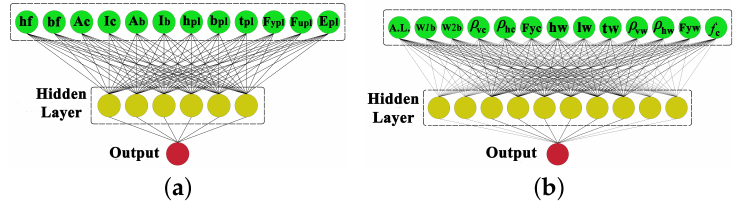
Figure 3. Proposed ANN models for shear walls. ( a ) SPSW, ( b )